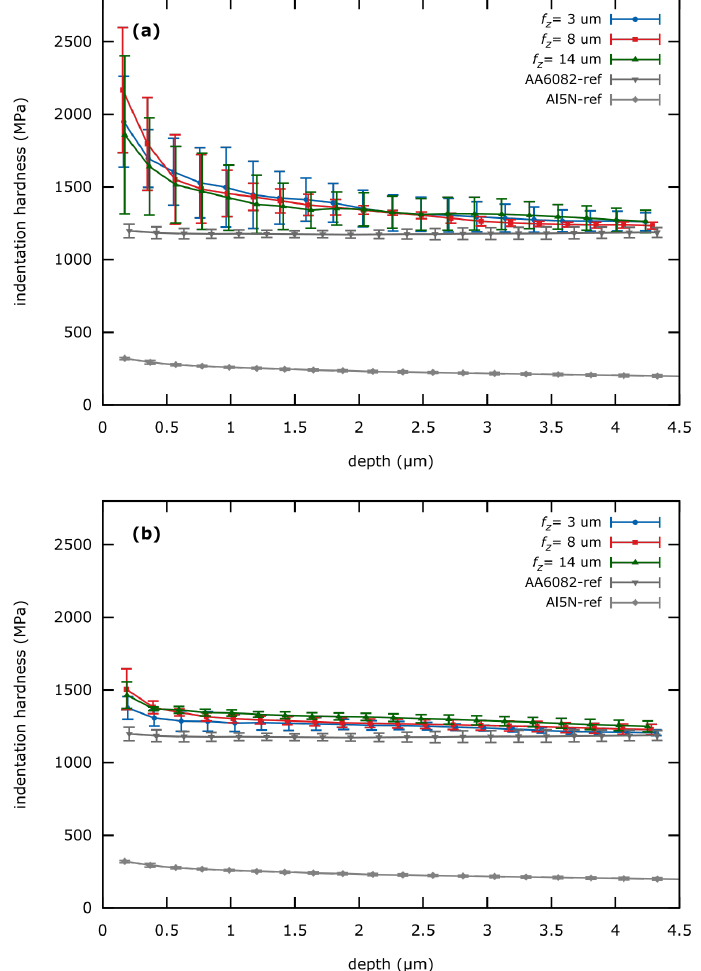
Figure 13. Hardness-depth-curves of machined surfaces compared to electropolished AA6082 and Al5N surfaces as a reference. ( a ) SC-tool machined surface ( b ) MD-tool machined